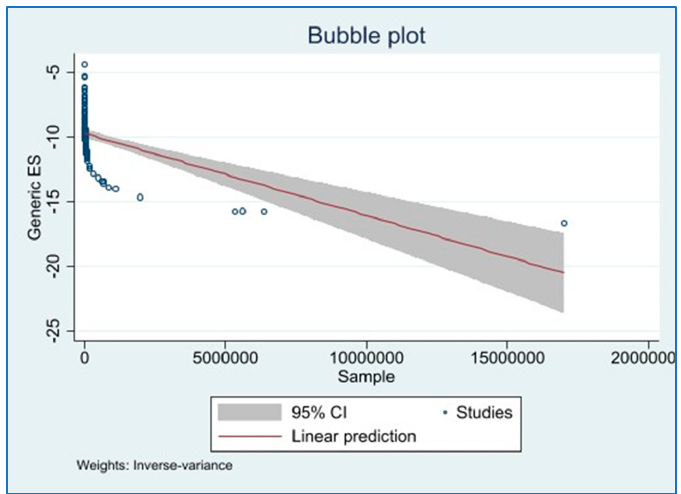
Figure 5. Meta-regression based on sample size.